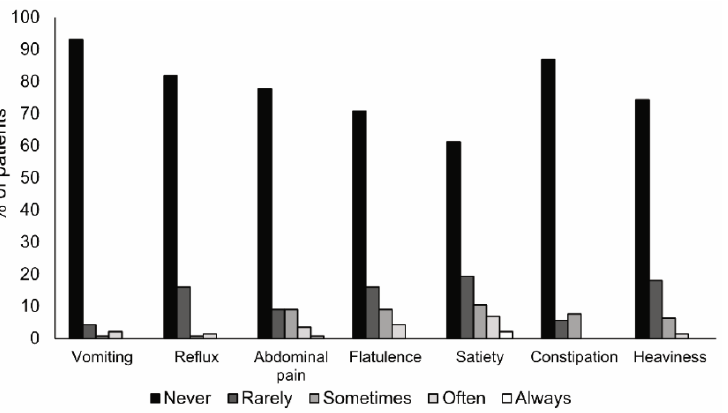
Figure 5. Frequency of tolerance symptoms after 12 weeks of treatment with a semi-elemental hydrolyzed whey protein diet. The bars show the frequency of nausea, vomiting, reflux, abdominal pain, flatulence, satiety, and constipation.